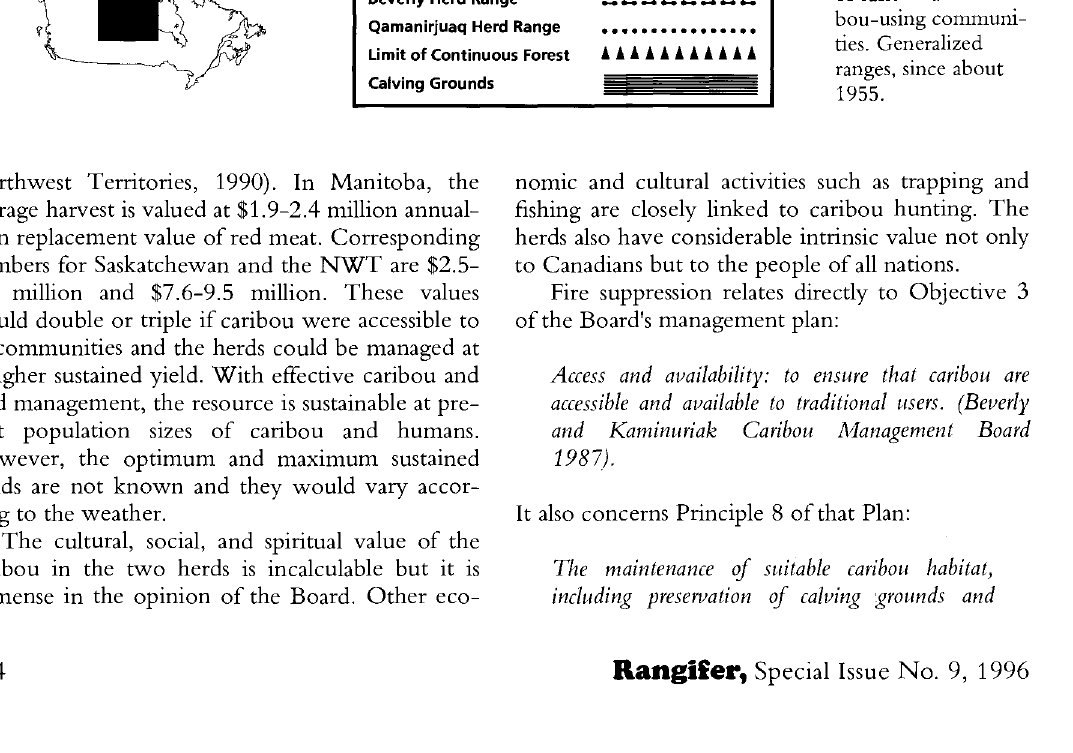
Fig. 1. Ranges of the Beverly and Qamanirjuaq herds of caribou and cari bou-using communi ties. Generalized ranges, since about